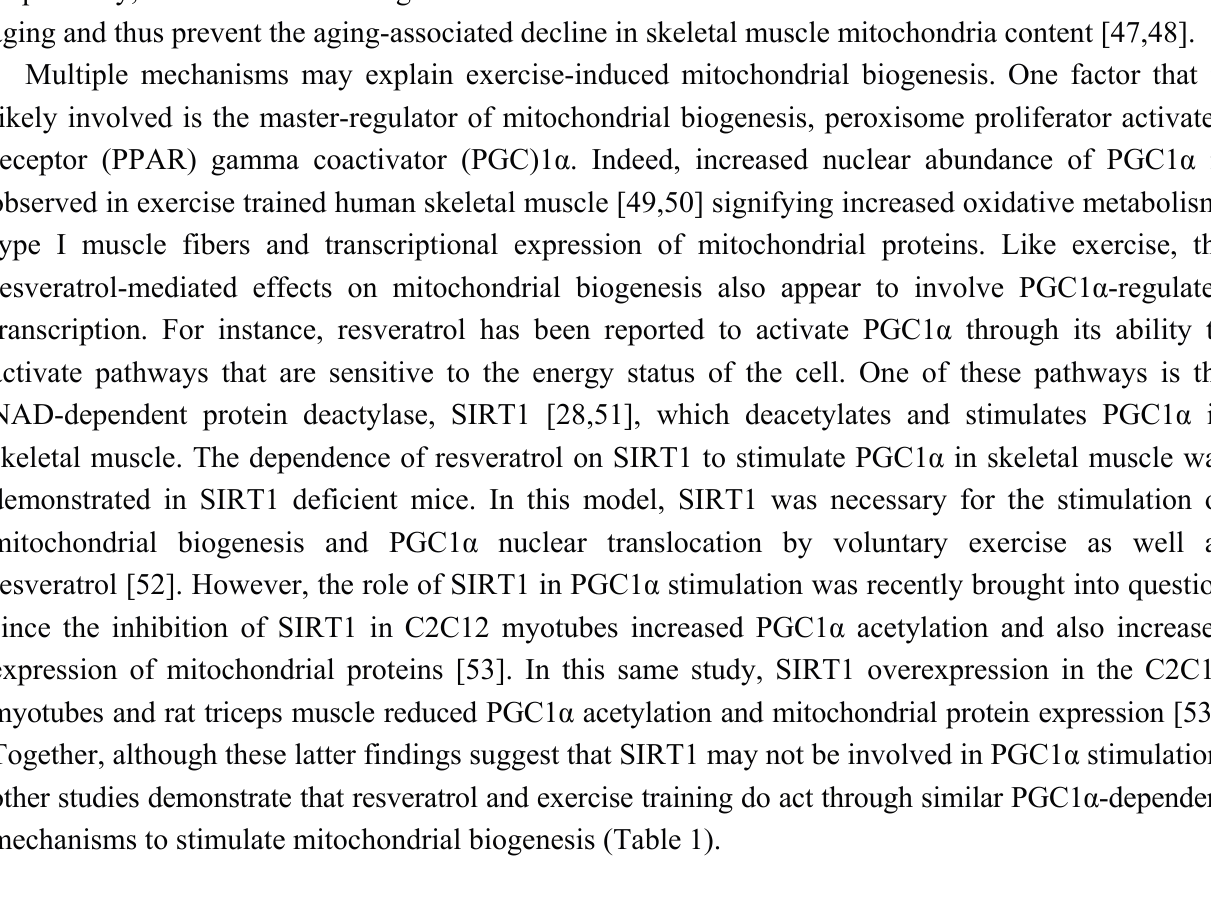
Table 1. Effects of exercise and resveratrol on molecular pathways. Exercise